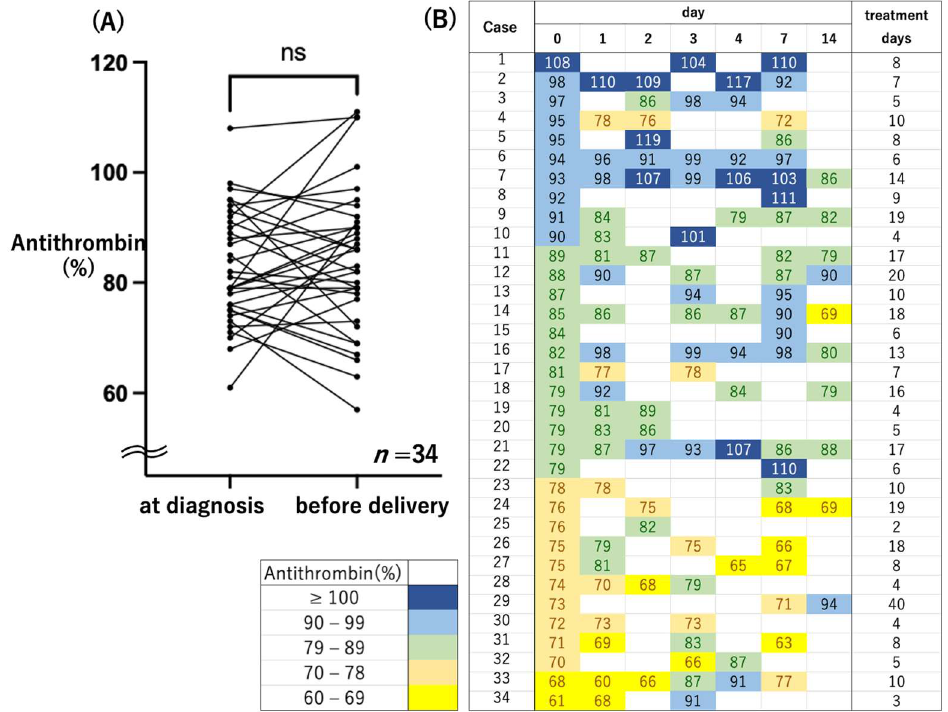
Figure 3. Plasma Antithrombin activity in the MgSO 4 treatment group. ( A ) Plasma antithrombin activity at diagnosis and just before delivery. ns, nonsignificant; p = 0.74 ( B ) Transition of plasma antithrombin activity from diagnosis to delivery. Treatment days means number of days from diagnosis to delivery. The degree of antithrombin activity was identified by the six colors shown in this figure (Navy: ≥100%; Blue: 90–99%; Green: 79–89%; Orange: 70–78%; Yellow: 60–69%).